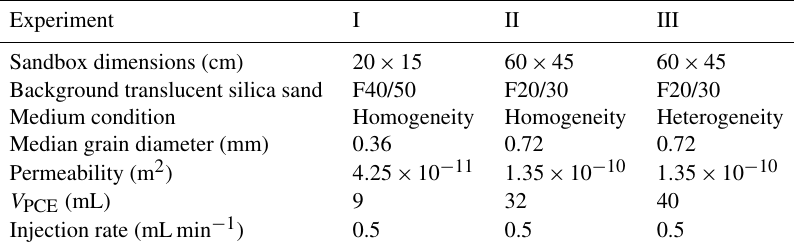
Table 1. Experimental conditions.